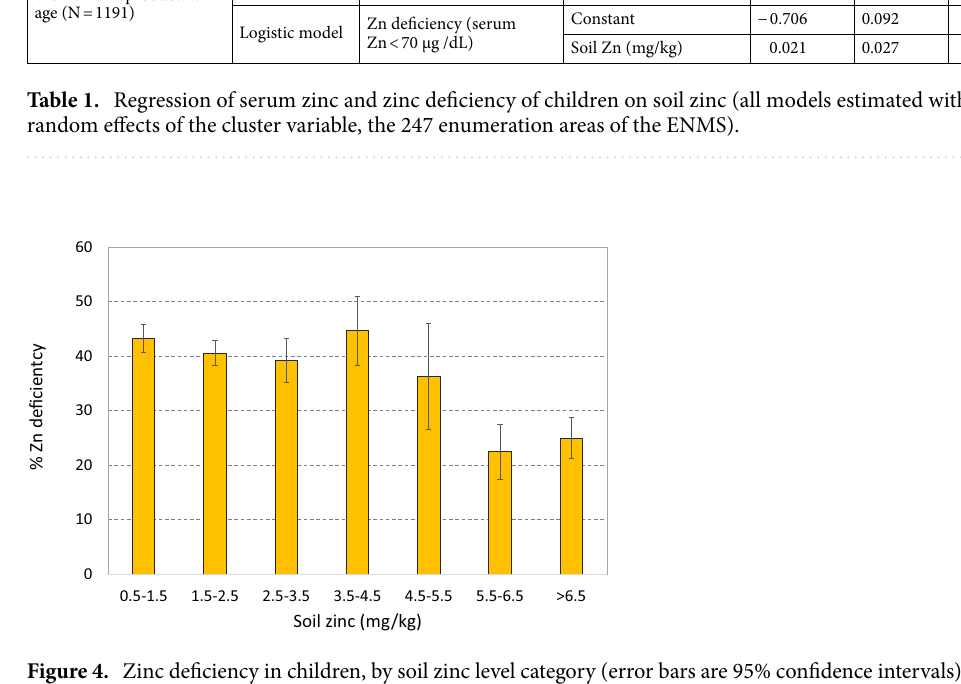
Figure 4. Zinc deficiency in children, by soil zinc level category (error bars are 95% confidence